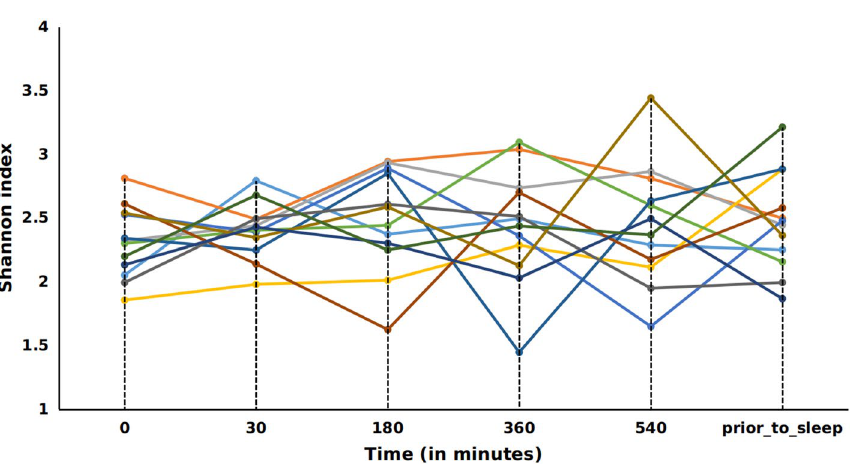
Figure 3. Shannon Diversity Index (richness and evenness) over time. OTUs are shown per subject as delineated by individual lines. X-axis units are shown as minutes post wake per